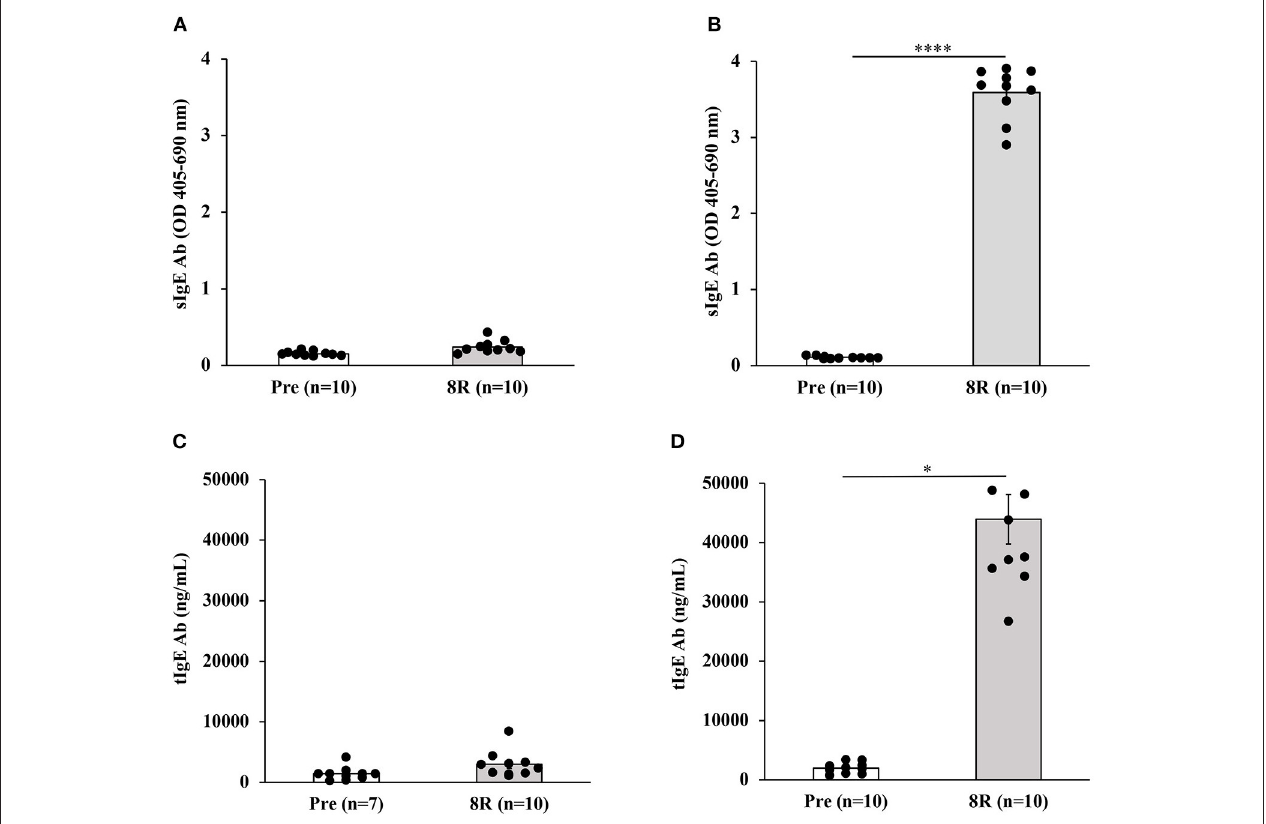
FIGURE 1 | Transdermal exposure to durum wheat (genomes AABB) SSPE elicited exposure-dependent SSPE-specific (s) IgE antibody responses and elevation of total (t) IgE in Balb/c mice that correlate with each other. Mice were exposed to SSPE or to saline as described in Materials and Methods. Blood was collected before 1st exposure (Pre) and after 8th exposure (8R). Plasma was used in measurement of SSPE-specific IgE levels (OD 405–690nm) using an ELISA method described previously. (A) SSPE-specific IgE levels in control mice. (B) SSPE-specific IgE levels in sensitized mice. **** p < 0.001; Ab, antibody. (C) Total IgE levels in control mice. (D) Total IgE levels in sensitized mice. * p <